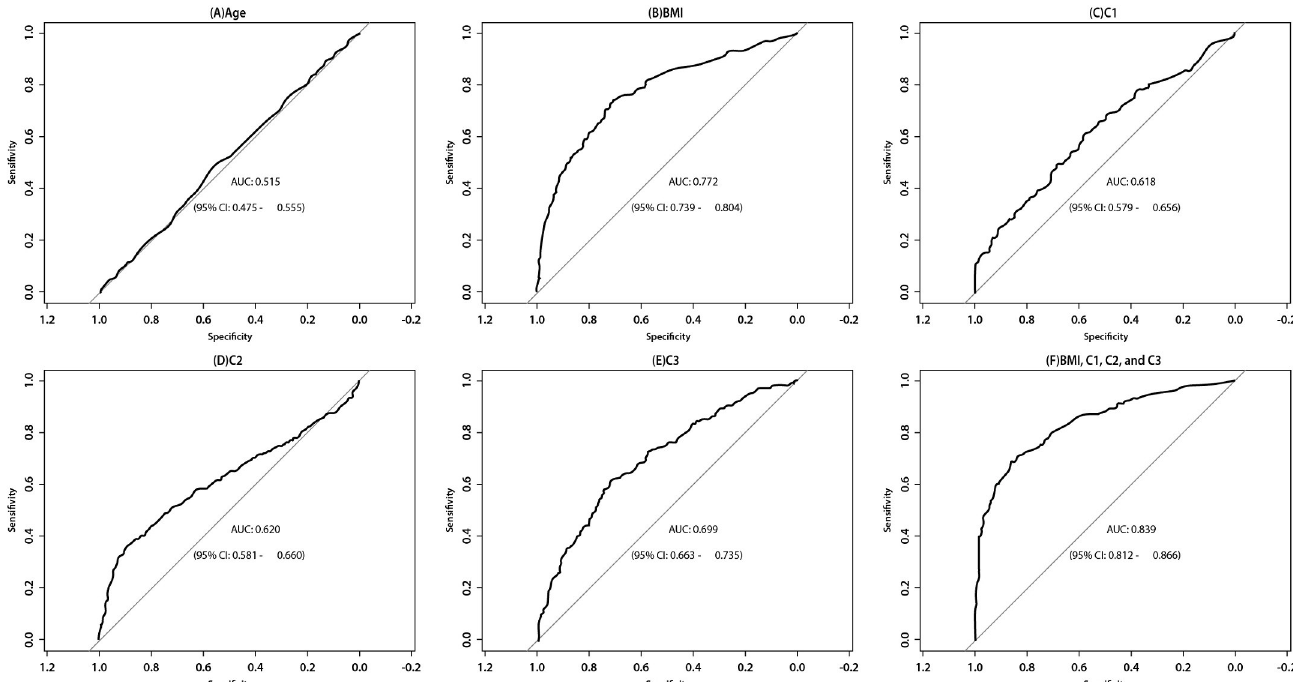
Fig 1. Area Under Curve (AUC) constructed to predict women with T2DM. Comparison of receiver operating characteristic curves for (A) Age, (B) Body mass index (BMI), (C) C1, (D) C2, (E) C3, and (F) BMI and C1, C2 and C3.